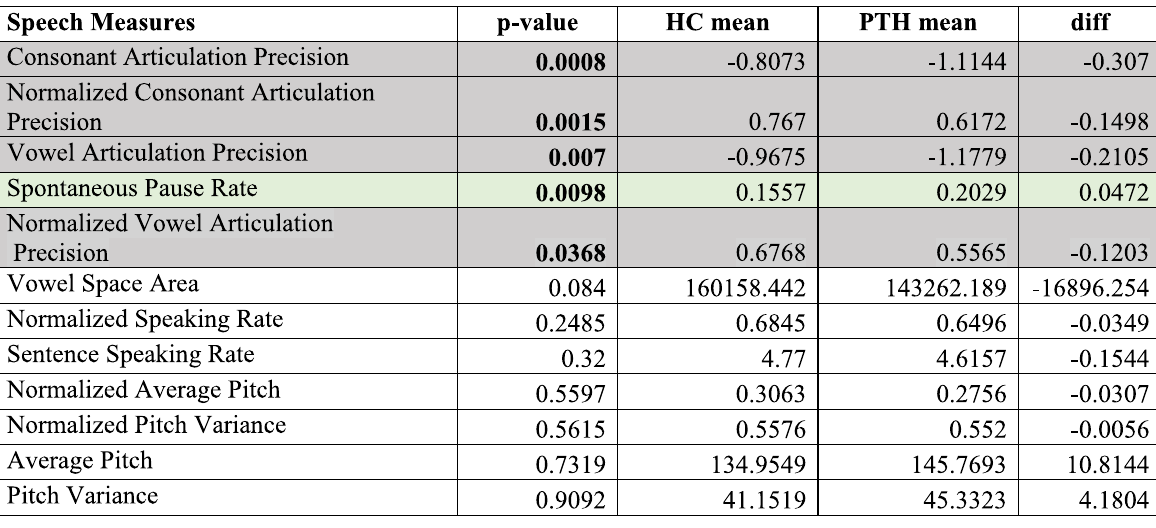
Table 3 and 4. show the speech measures, the p -values for the healthy controls/PTH differences (p-value com- puted based on a Chi Squared Likelihood Ratio Test),